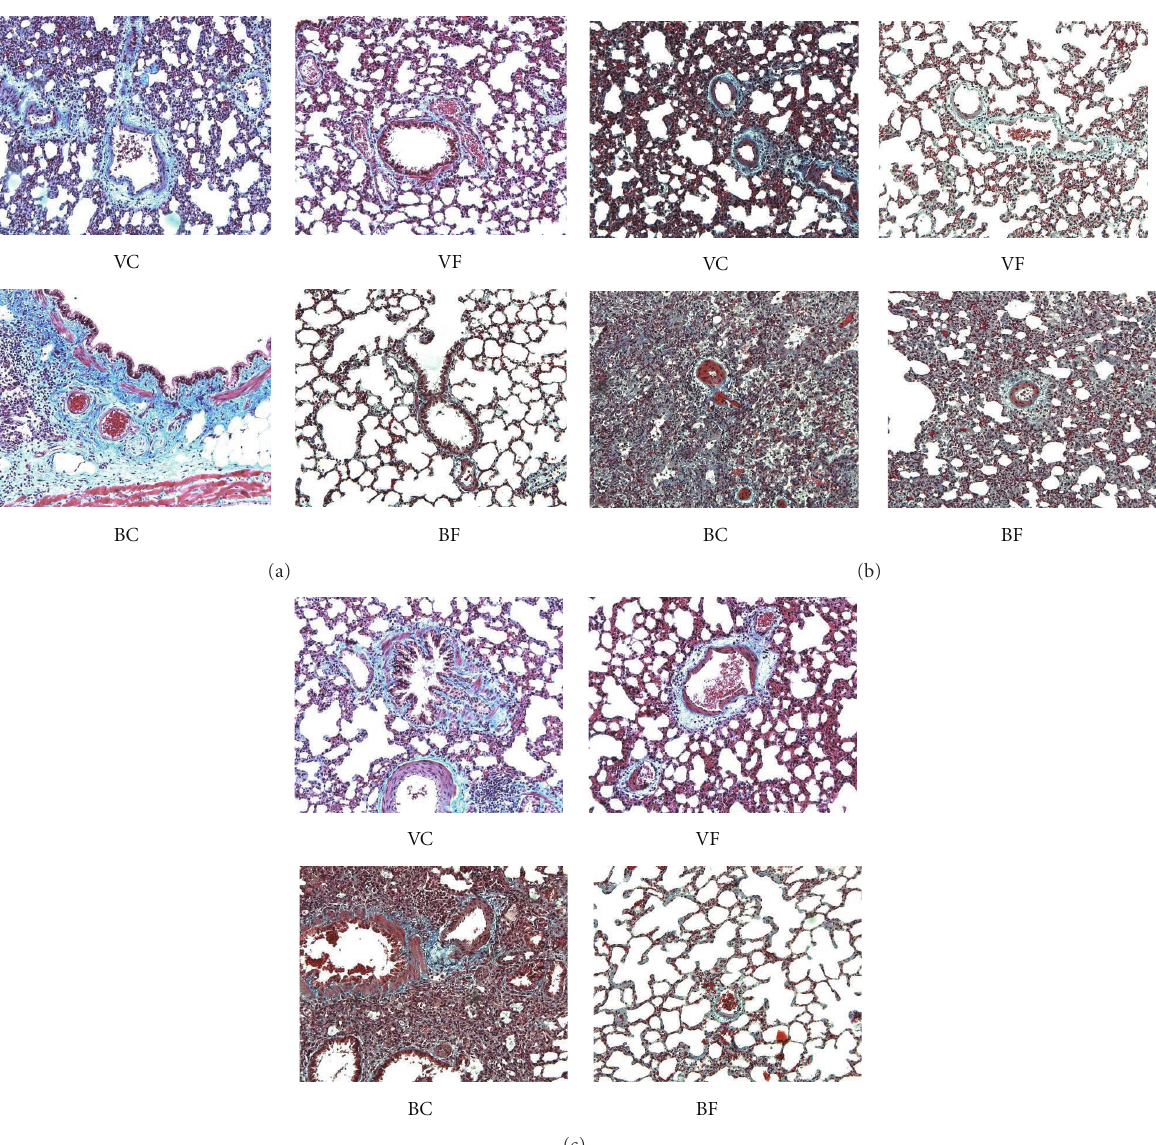
Figure 3: (a) Histological sections of rat lungs of the four groups sacrificed at day 2. Mild septal congestion and bronchial inflammatory reaction is found in rats treated with the vehicle and corn oil. Severe septal and bronchial inflammation and the increased presence of collagen (blue) are seen in bleomycin treated rats on the corn oil diet. Inflammation and vascular thickness are less severe when the diet is flaxseed oil. Stain: Masson’s Trichrome, 200X. (b) Histological sections of rat lungs of the four groups sacrificed at day 7. The VC-treated rat lungs show modest septal inflammation and a mild increase of adventitial edema and fibrosis. No damage was observed in VF treated rats. Bleomycin treated rats on the corn oil diet present di ff use inflammation and septal thickening, severe vascular thickening with markedly decreased lumen patency and bronchitis with increased presence of collagen (blue). Bleomycin treated rats on the flaxseed oil diet had less severe damage with not so prominent septal thickness, more patent arterial lumina and less fibrosis. Stain: Masson’s Trichrome, 200X. (c) Histological sections of rat lungs of the four groups sacrificed at day 21. The vehicle and corn oil caused di ff use septal and bronchial inflammation with increased collagen (blue) around the bronchial pulmonary arteries, and in the septa. No similar damage was observed in VF rats. Septal and bronchial inflammation is very severe in lungs of rats receiving bleomycin and on the corn oil diet, with vasculitis and fibrosis. The peribronchial arterioles were particularly involved with almost total obstruction of their lumen. Flaxseed oil diet markedly attenuated the bleomycin-induced damage both as septal inflammation and vasculitis. While the lungs of bleomycin + corn oil-treated rats were similar at 7 and 21 days, the lungs of bleomycin + flaxseed oil-treated rats were markedly improved at 21 days versus those of rats sacrificed after 7 days. Stain: Masson’s Trichrome, 200X. Abbreviations used: VC (vehicle, corn oil), VF (vehicle, flax seed oil), BC (bleomycin, corn oil), and BF (bleomycin, flax seed